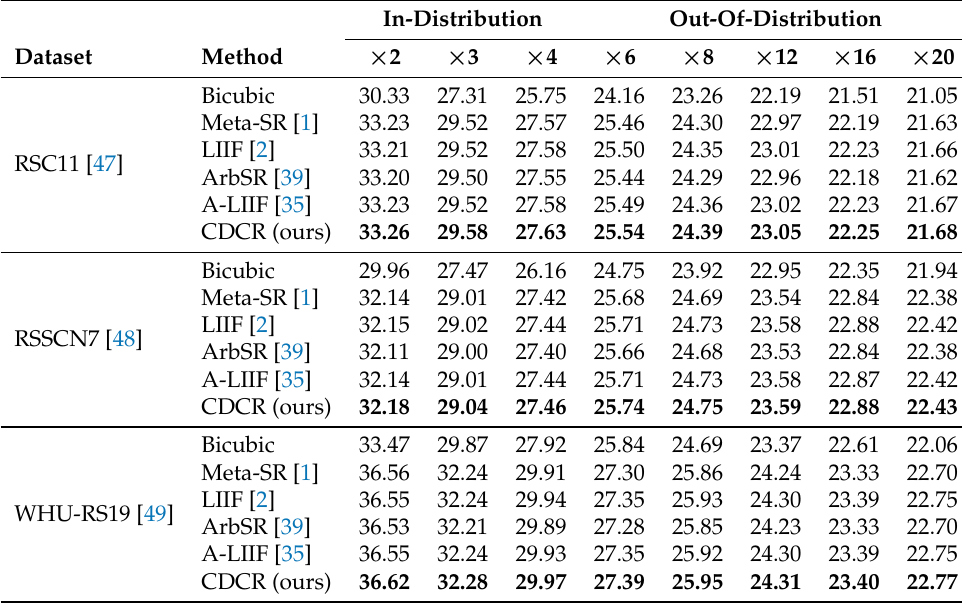
Table 1. Quantitative comparison of various methods across multiple scale factors using PSNR(dB). The best values for each scale factor across different datasets are highlighted in bold . In-Distribution Out-Of-Distribution